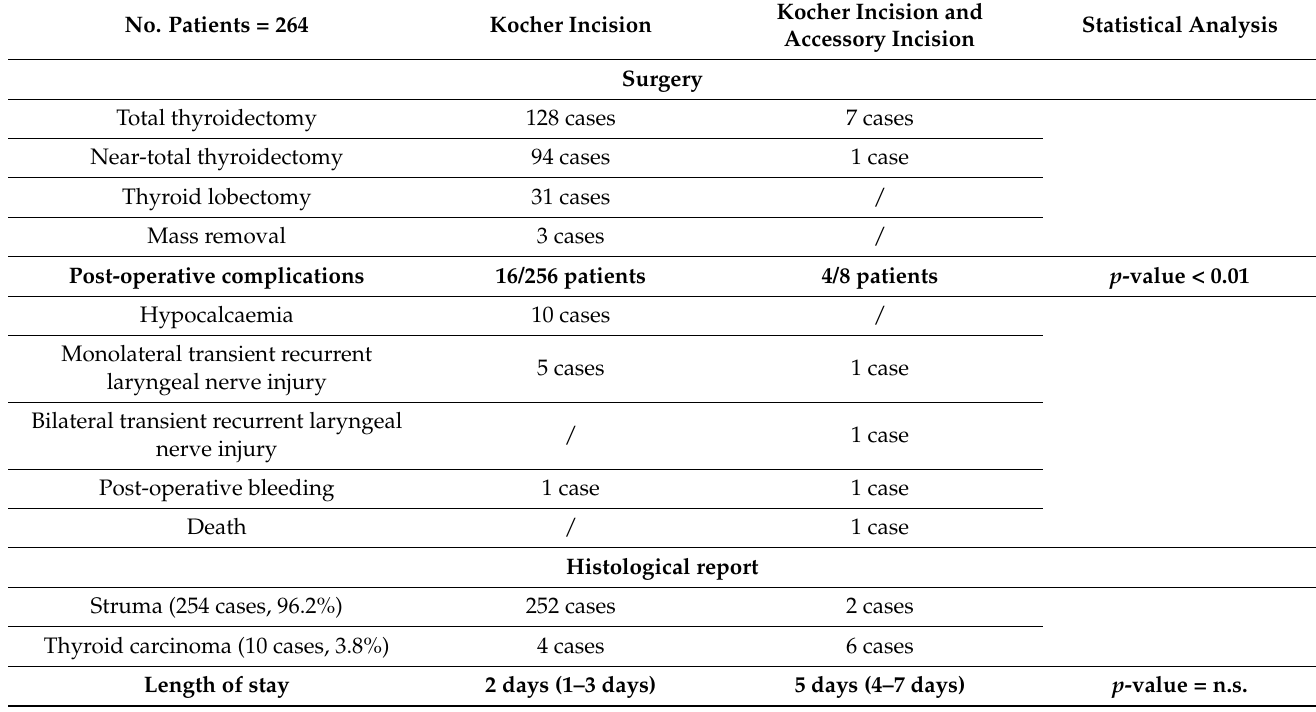
Table 2. Results of the clinical series and statistical